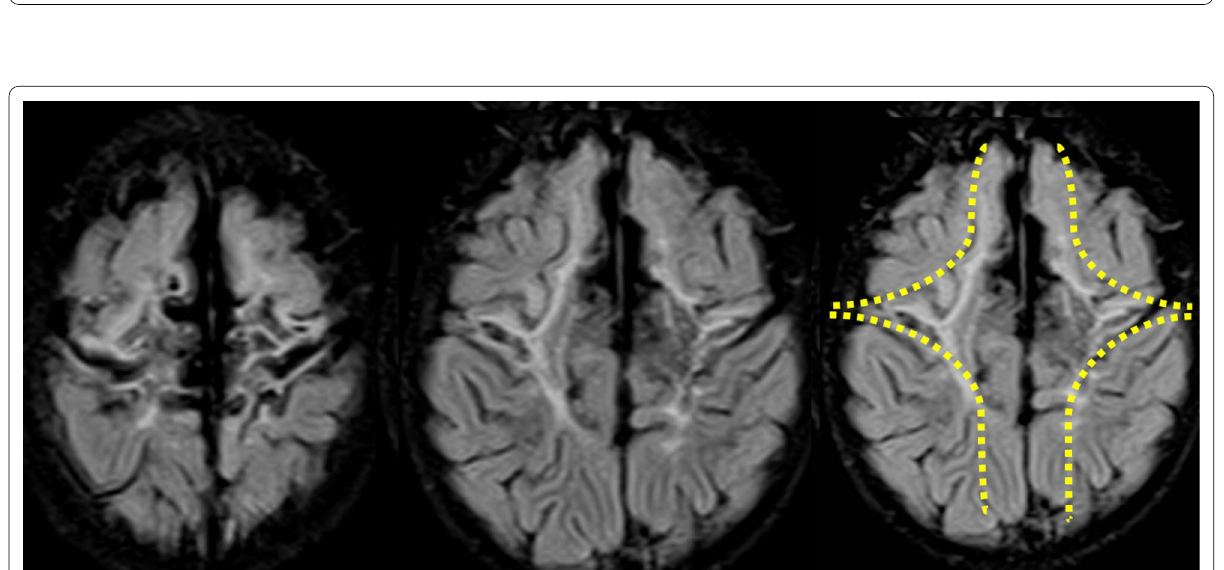
Fig. 4 The severe subtype of perirolandic injury with greater PCL involvement and marked localised atrophy, widening the interhemispheric fissure, with an inverted‑V configuration (yellow dotted line)